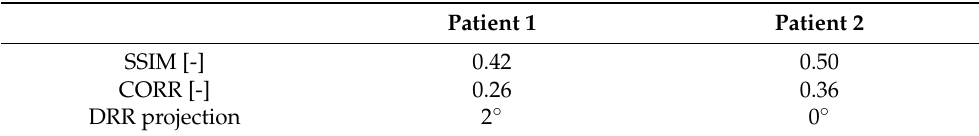
Table 3. Summary of highest similarity results and their DRR projection per